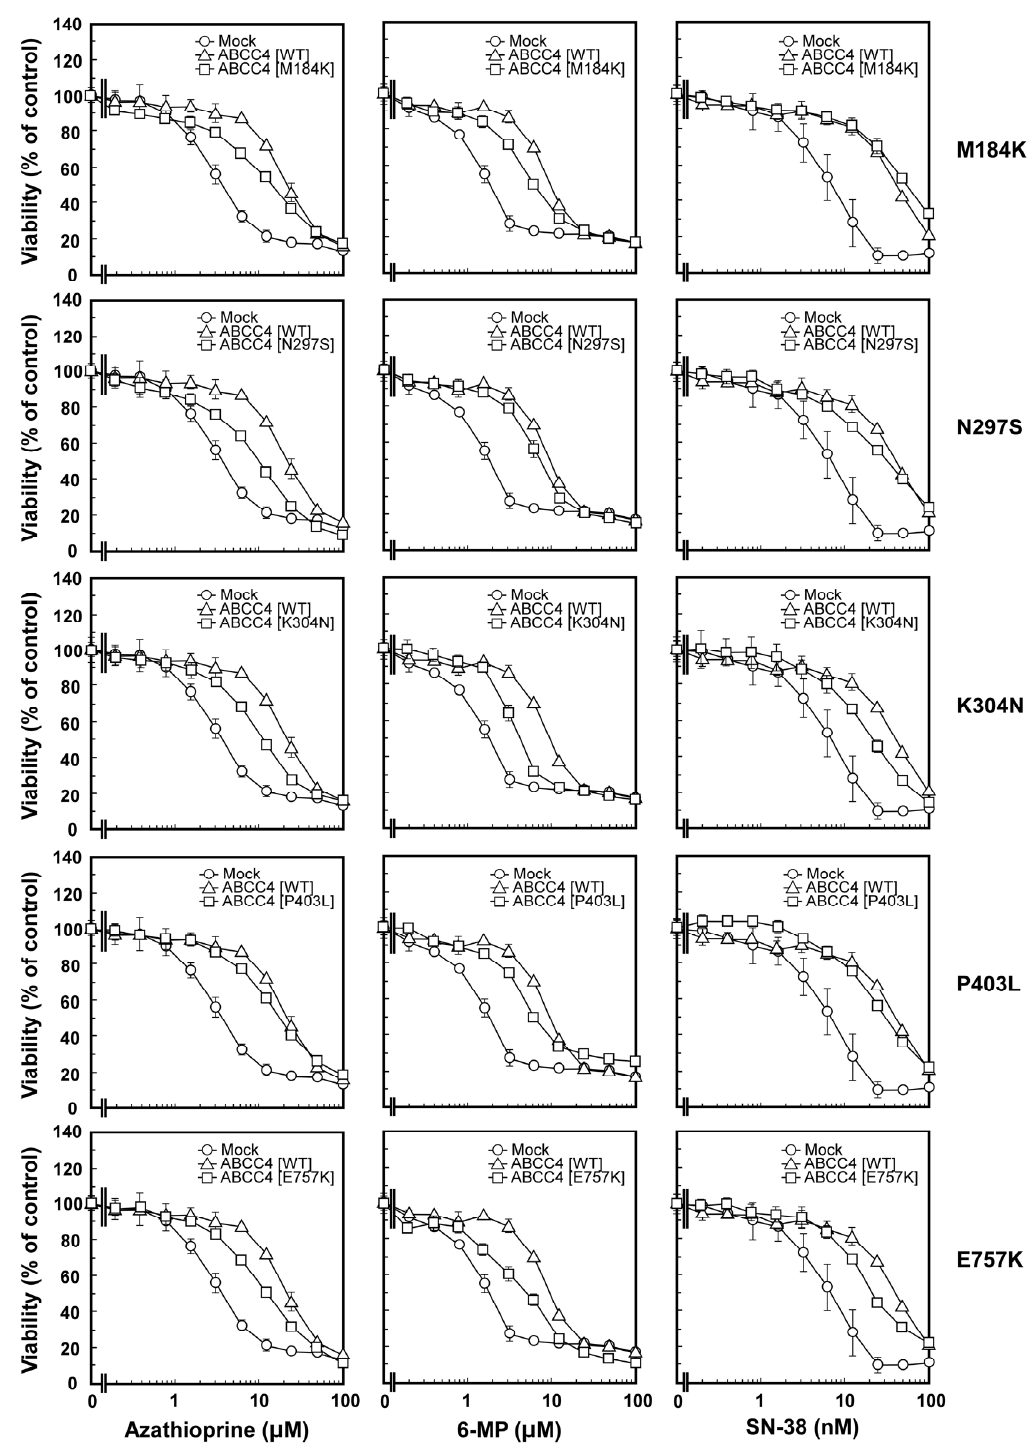
Figure 5. Anticancer drug resistance properties of the cells established using the Flp-In™ system. Anticancer drug resistance properties of cells were evaluated by using the 3-(4,5-Dimethyl-2-thiazol- 2-yl)-2,5-diphenyl-2H-tetrazolium bromide (MTT) assay, as described in Materials and Methods. Data are expressed as mean values ± S.D. ( n = 3–6).